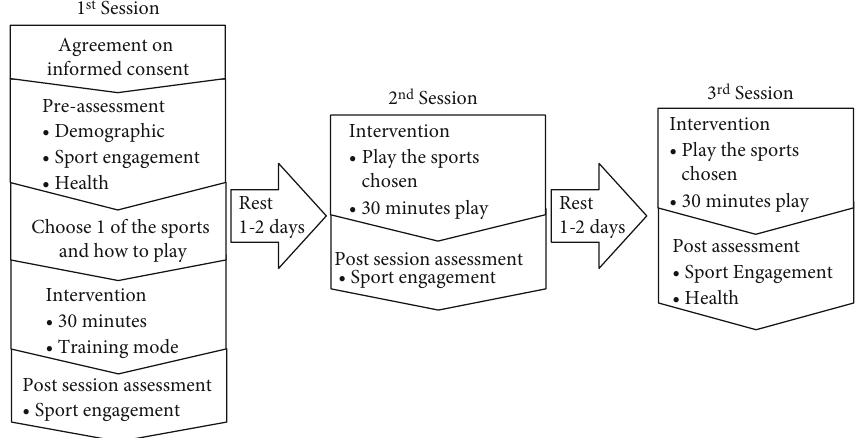
Figure 2: Intervention fl